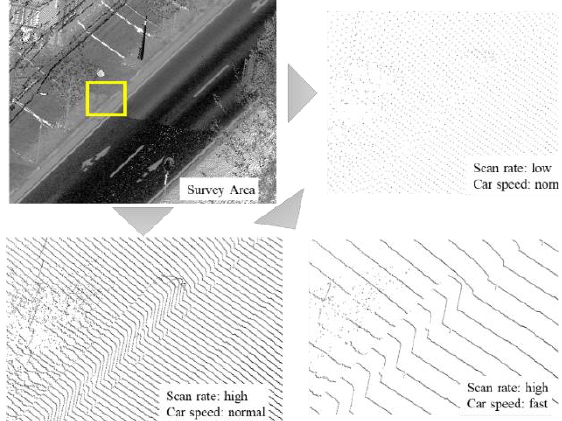
Figure 1. Point cloud measured under different